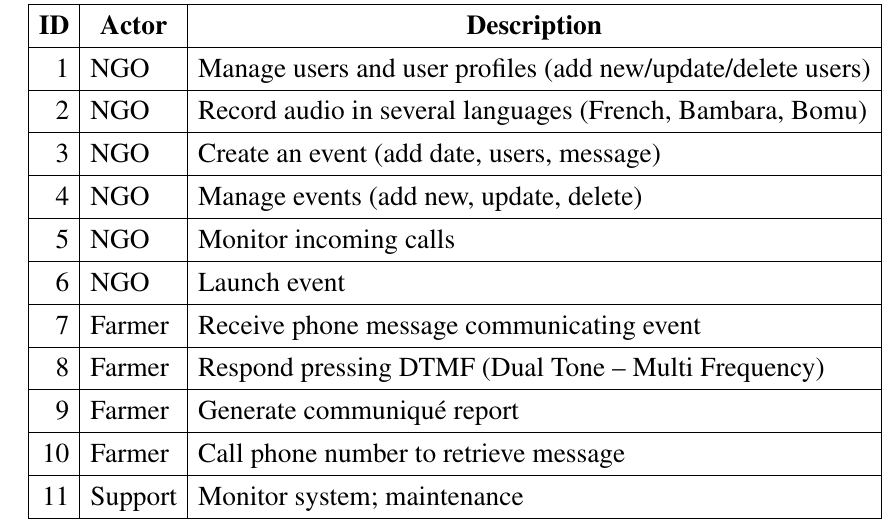
Table 1. Stakeholders and their concerns for the Tabale use